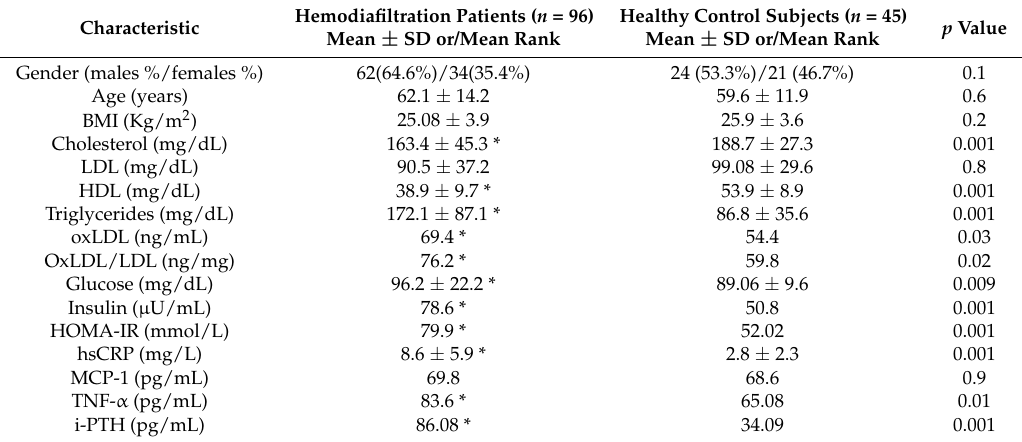
Table 1. Differences between hemodiafiltration patients ( n = 96) and healthy control subjects ( n = 45) (* p < 0.05).